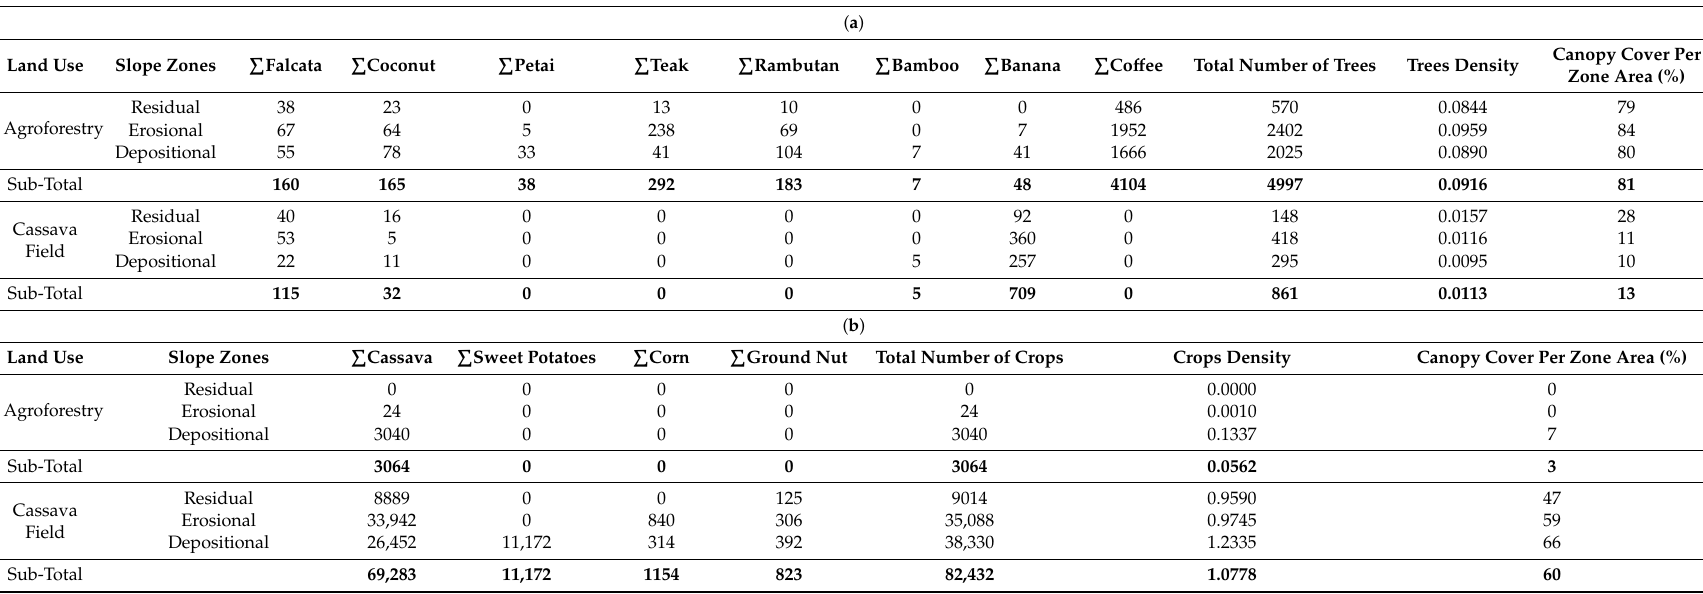
Table 2. ( a ) Trees in the Sampling Area of Agroforestry and Cassava Field. ( b ) Crops in the Sampling Area of Agroforestry and Cassava Field. ( a